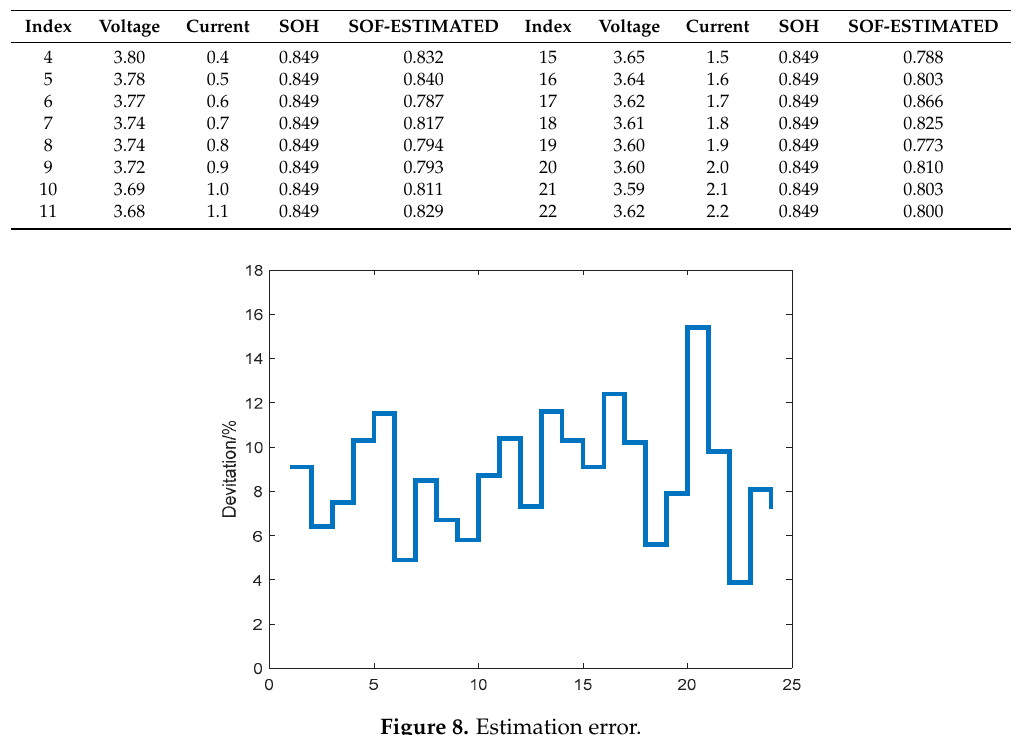
Table 1. Estimation results of the first battery.